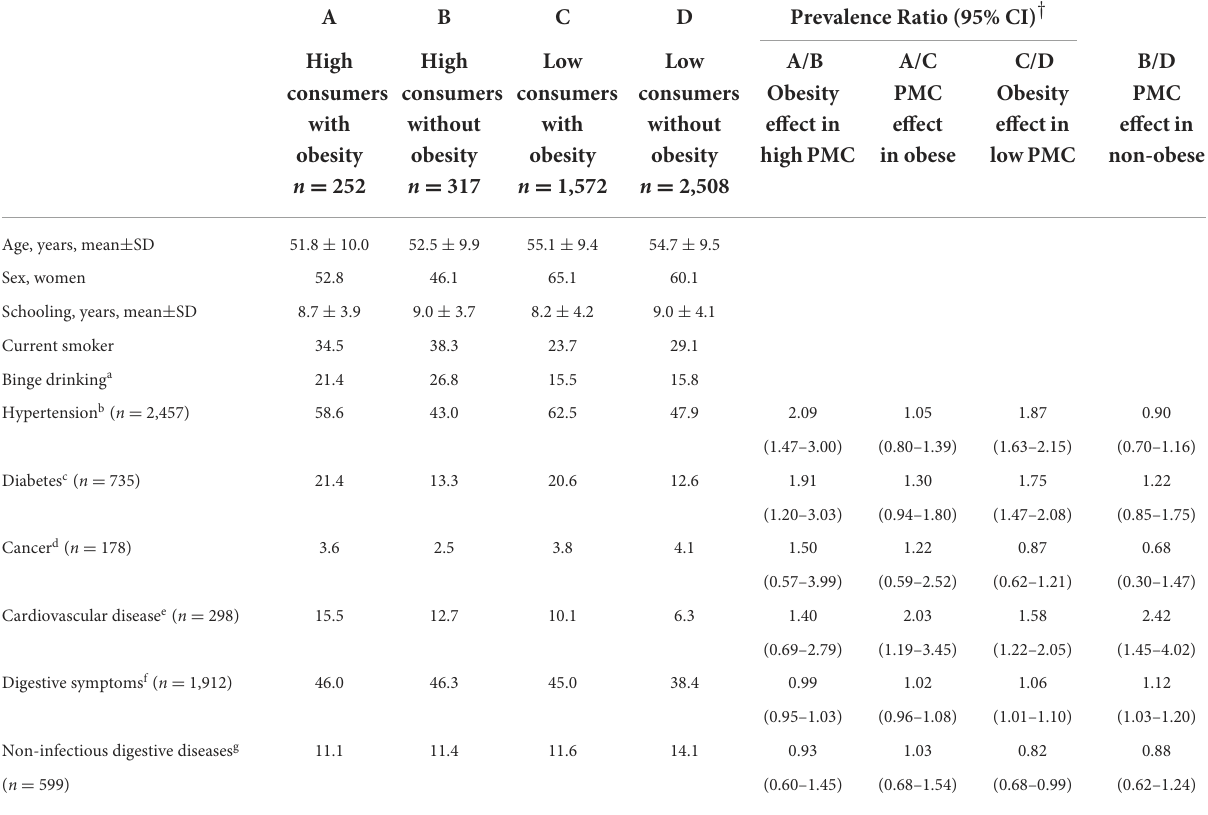
TABLE 6A Association of chronic diseases and processed meat consumption by obesity status in MAUCO participants.